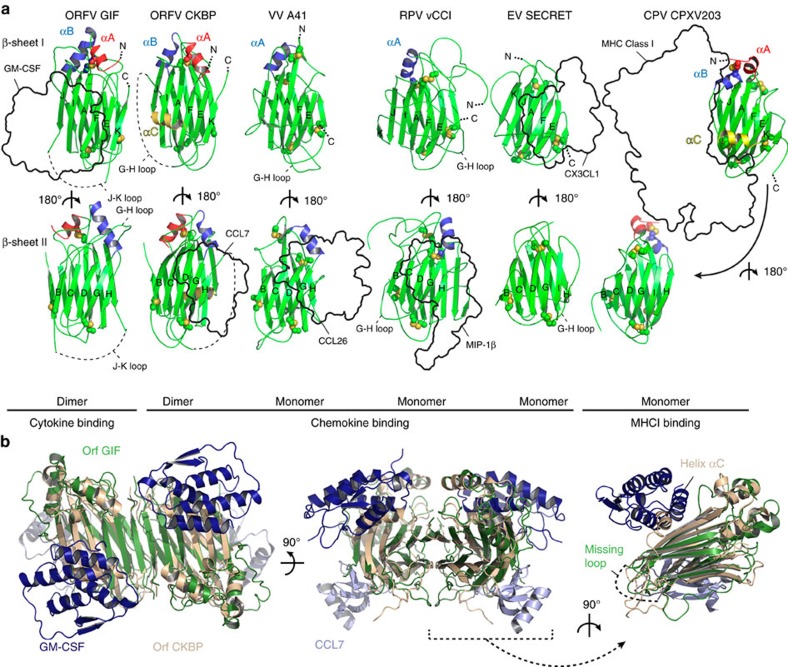
Structural comparison of Orf GIF with other members of the Poxviral Immune Evasion (PIE) superfamily.(a) Structures for Orf virus GIF (PDB code 5D28),Orf virus CKBP (PDB code: 4ZK9), Vaccinia virus A41 (PDB code: 2VGA), Rabbitpox virus vCCI (PDB code: 2FFK), Ectromelia virus SECRET domain (PDB code: 3ON9) and Cowpox virus CPXV203 (PDB code: 4HJK) are shown in cartoon representation with labeled secondary structure elements and disulfides shown as spheres. Binding ligands are labeled and shown as a black outline. Shared secondary structure elements consist of 2 β-sheets (I: β-strands βJ, βI, βA, βF, βE, βK and II: β-strands βB, βC, βD, βG, βH) and one common α-helix linking β-strands βF and βG present in all proteins except the SECRET domain. Within the β-sandwich, six cysteines are fully conserved throughout all PIE superfamily members, resulting in three disulfide bonds stabilizing the β-sandwich core. The related Orf GIF and Orf CKBP proteins contain one and two extra α-helices, respectively, which are not present in the folds of vaccinia virus A41, rabbit pox virus vCCI and ectromelia virus SECRET domain. However, cowpox virus CPXV203 contains two extra C-terminal α-helices of which the second one is present at an equivalent position as the C-terminal helix observed in Orf CKBP. (b) Structural alignment of GIF from the GIF:GM-CSF complex (GIF: green, GM-CSF: dark blue) with Orf CKBP bound to CCL7 (CKBP: wheat, CCL7: light blue).